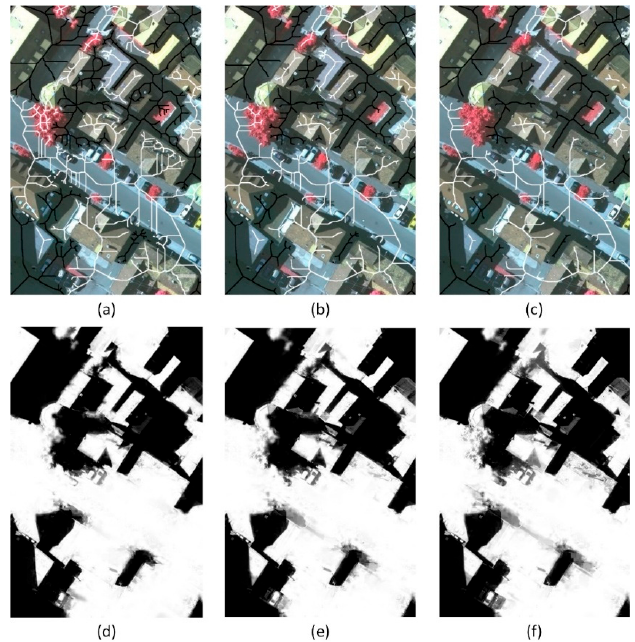
Figure 13. The final skeleton marks on the original images and the shadow detection results: ( a ) skeleton operation results of 5 × 5; ( b ) skeleton operation results of 10 × 10; ( c ) skeleton operation results of 15 × 15; ( d ) shadow mask of 5 × 5; ( e ) shadow mask of 10 × 10; and ( f ) shadow mask of 15 × 15.